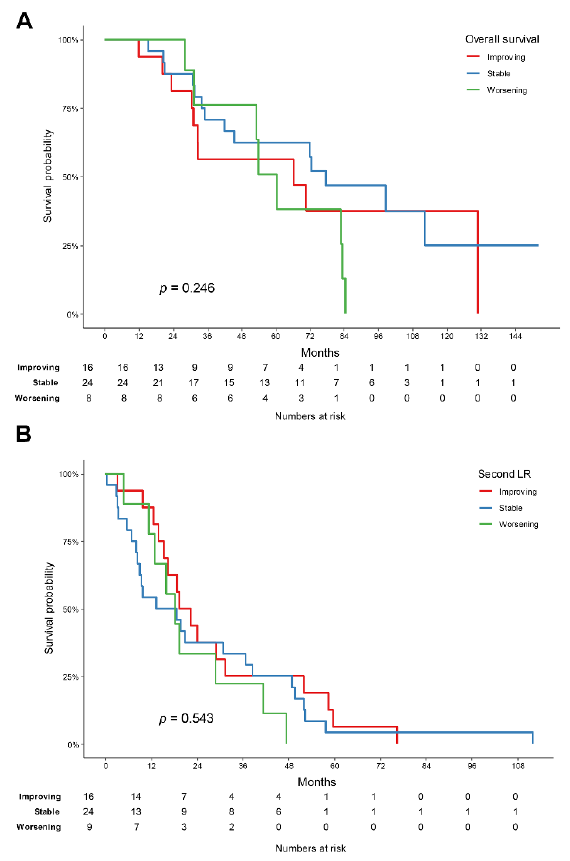
Figure 2. Kaplan–Meier survival graph for each group of improving, stable, and worsening, according to the change in tumor grade: ( A ) overall survival and ( B ) second local recurrence.